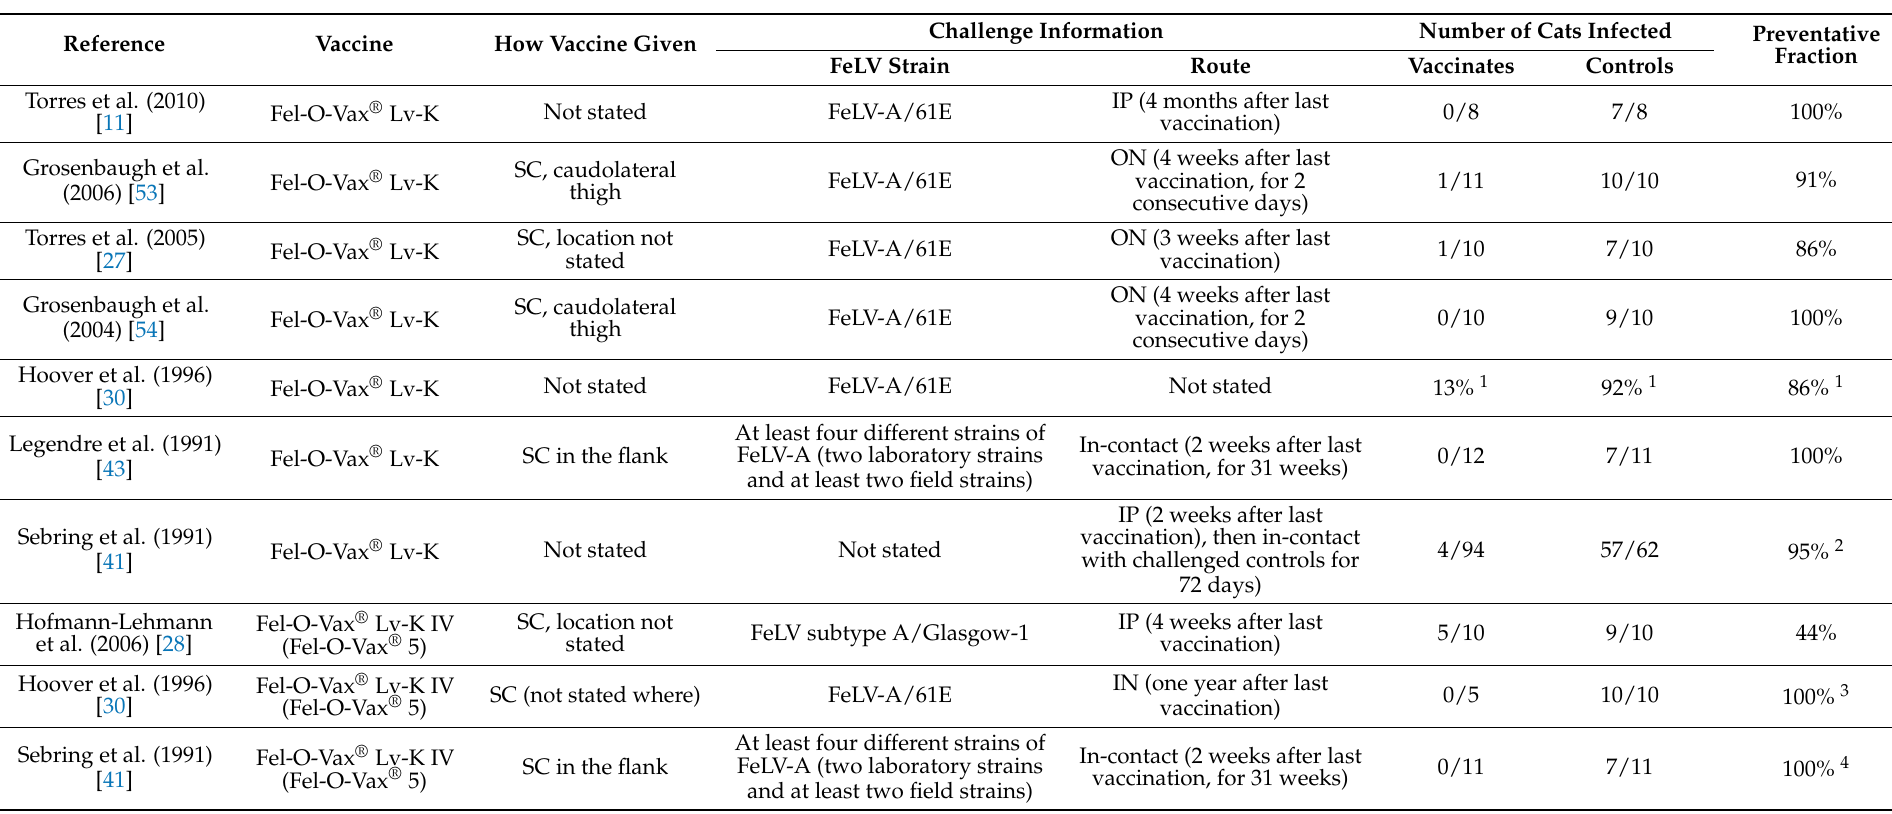
Table 3. Summary of vaccine efficacy studies for Fel-O-Vax ® Lv-K and Fel-O-Vax ® 5 (marketed as Fel-O-Vax ® Lv-K IV in the USA). Preventative fraction is defined as ([percentage persistent viraemia in controls]—[percentage persistent viraemia in vaccinates]/percentage persistent viraemia in controls × 100). Since both Fel-O-Vax ® Lv-K and Fel-O-Vax ® 5 are inactivated whole-virus vaccines derived from the same seed virus (FeLV-A/61E), challenge with FeLV-A/61E virus is considered homologous FeLV challenge, while challenge with a strain other than FeLV-A/61E is considered heterologous FeLV challenge. IP = intraperitoneal, ON = oronasal, IN = intranasal, SC =